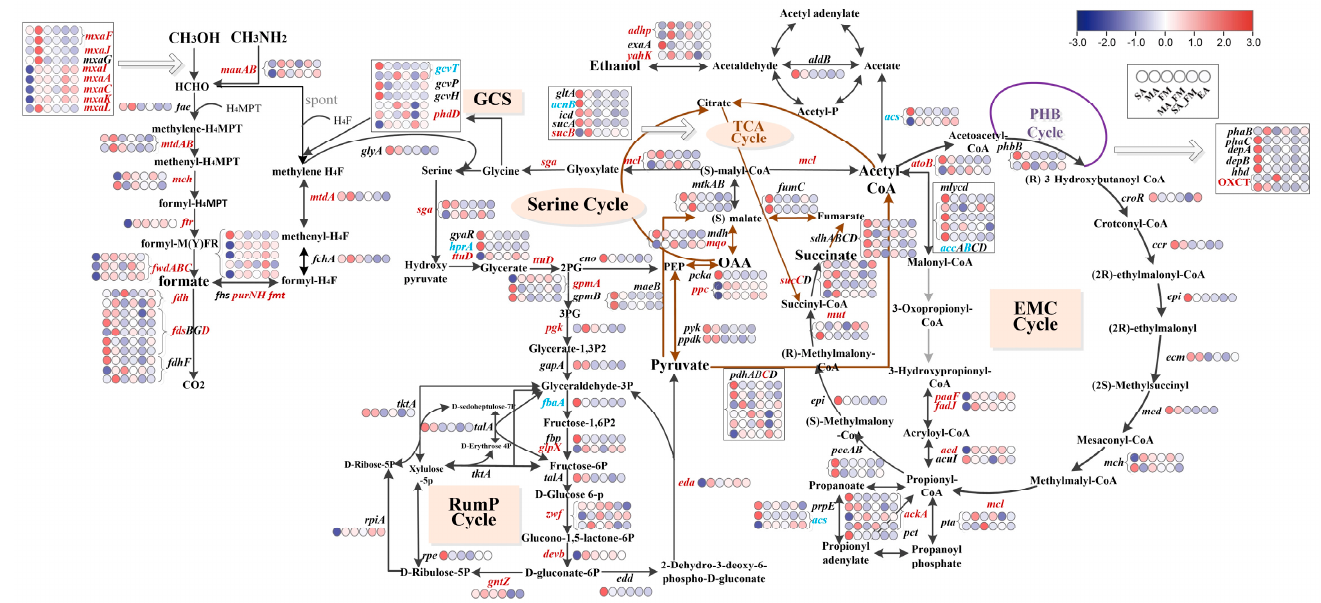
Figure 5. The central carbon metabolic pathways in M. rhodesianum strain MB200 and proposed EMC pathway containing partial propionate metabolic pathway based on our customized genomic and transcriptomic analyses. Genes encoding enzymes for each step are listed in Table S1. The common up– (red) and down– (blue) regulated genes are marked. SA: succinate; MA: methanol; FM: formaldehyde; MA_FM: methanol and formaldehyde; SA_FM: succinate and formaldehyde; EA: